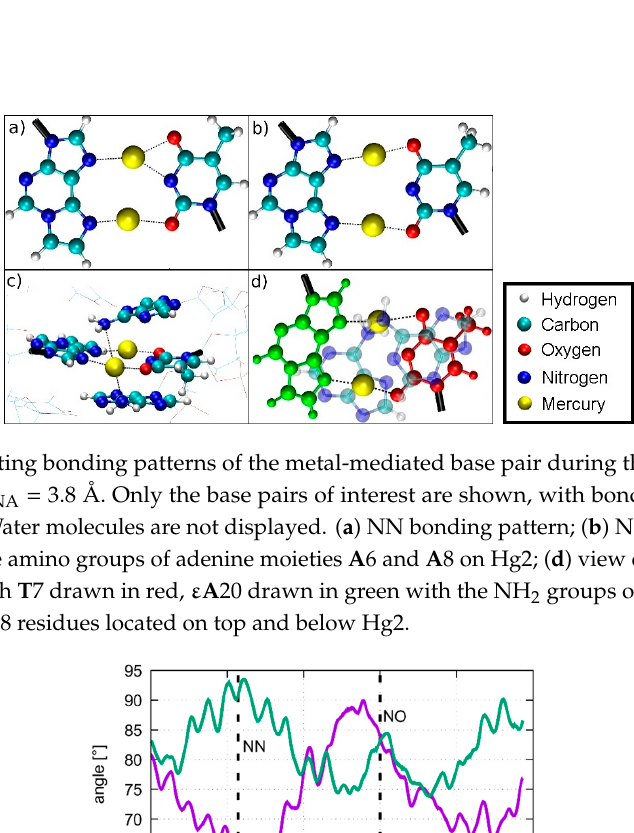
Figure 12. Comparison of free energies for the dissociation of structures 1 – 3 . Structures 1 and 2 contain